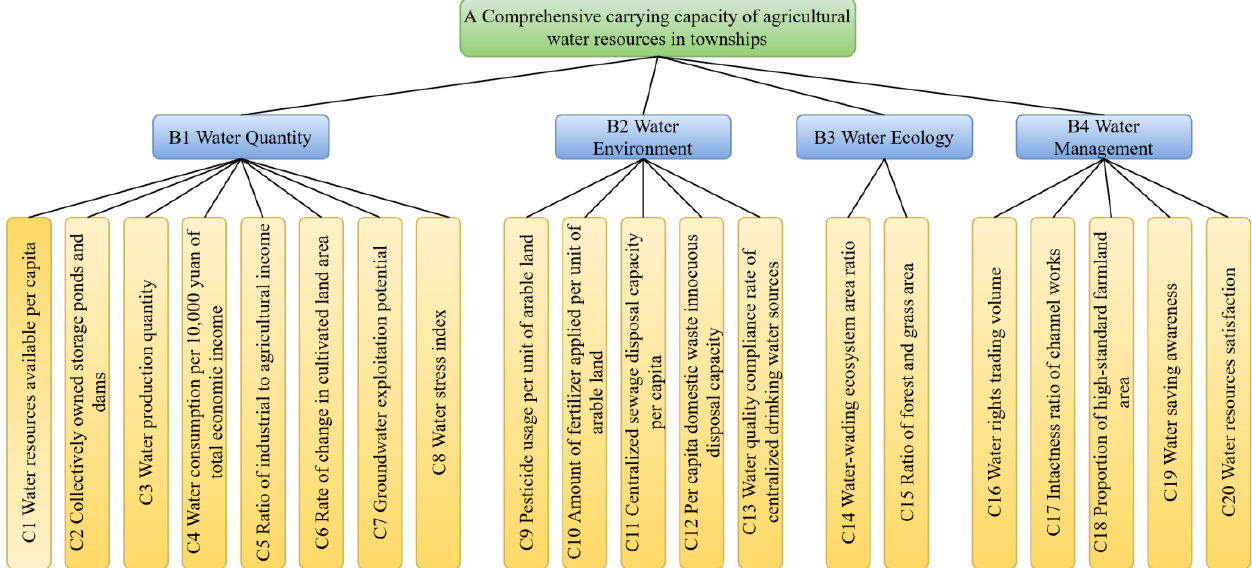
1 Table A5. B1-C judgment matrix. B1